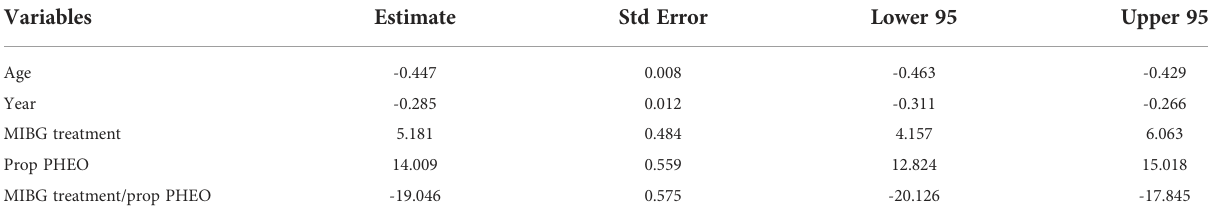
TABLE 5 Regression model comparing PFS between [ 131 I]MIBG and [ 177 Lu]Lu-DOTA-TATE considering that the treatments do not affect equally the adrenal and extra-adrenal primary location.